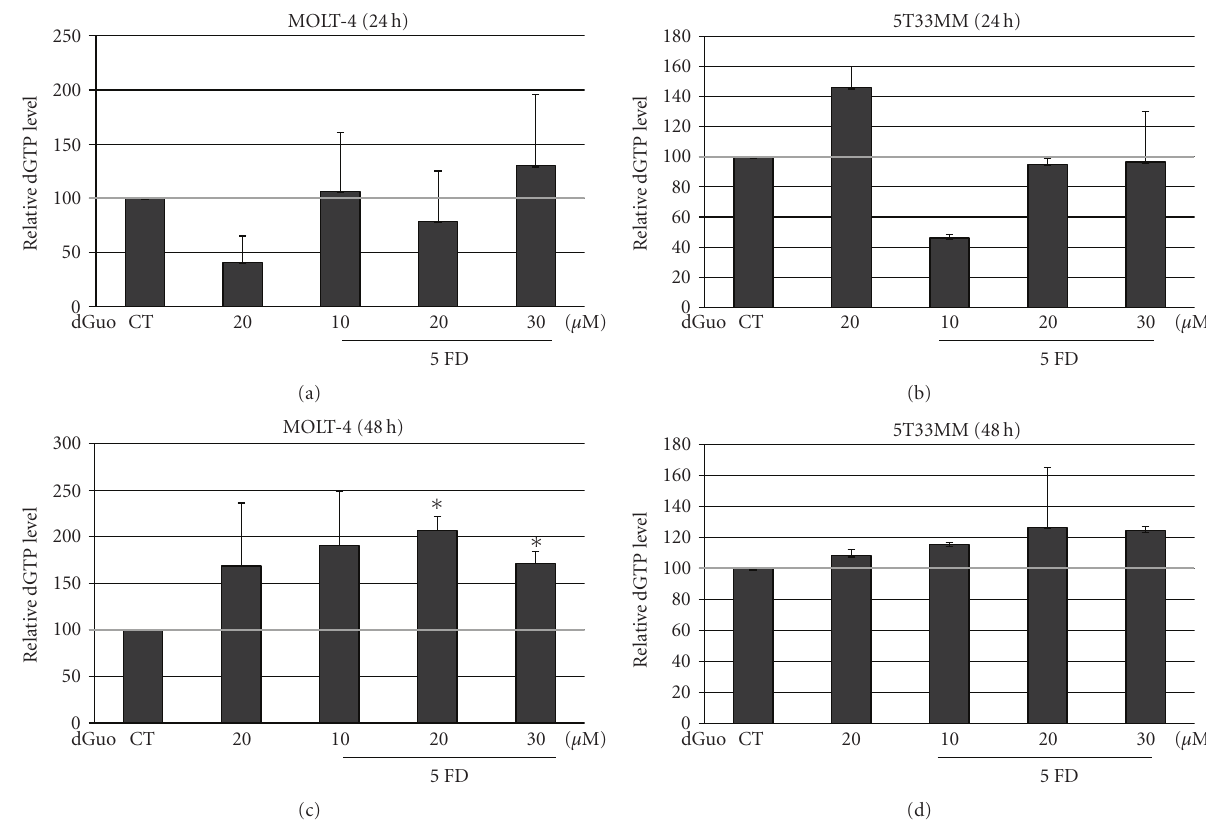
Figure 2: E ff ect of forodesine on dGTP levels in MM cells. The relative amount of dGTP was determined in MOLT-4 and 5T33MM cells, treated with 5 μ M forodesine and 10, 20, or 30 μ M dGuo at 24 hours (a, b) and 48 hours (c, d). The mean value + SD is shown of 3 independent experiments; ∗ P < . 05 compared to CT, CT = control and FD =